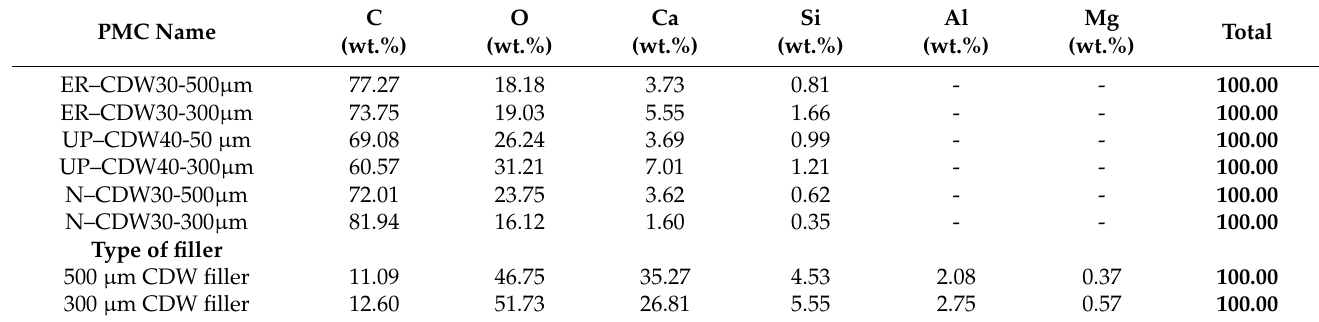
Table 5. Polymer matrix composites and embedded fillers elemental analysis.